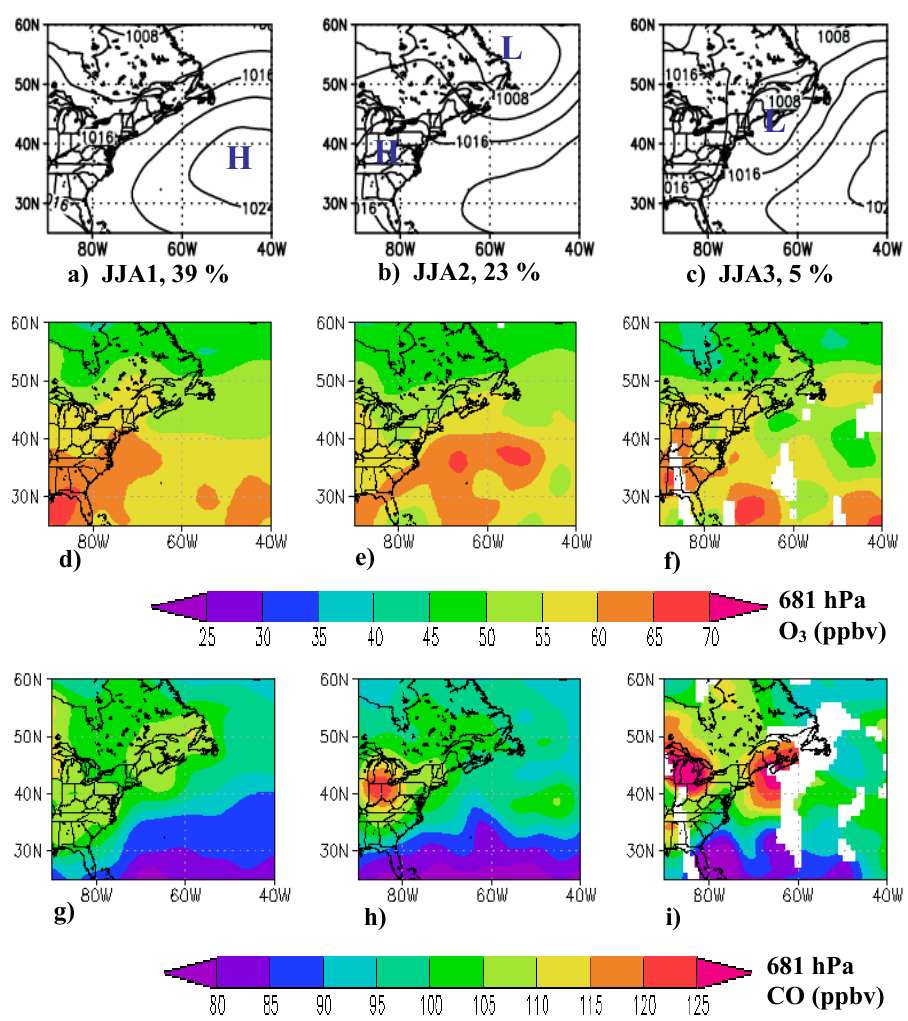
Fig. 12. Mean sea level pressure (SLP) (hPa) analyses during 2005 and 2006 for map types JJA1 – JJA3 (a–c) and corresponding 681hPa O 3 (d–f) and CO (g–i)